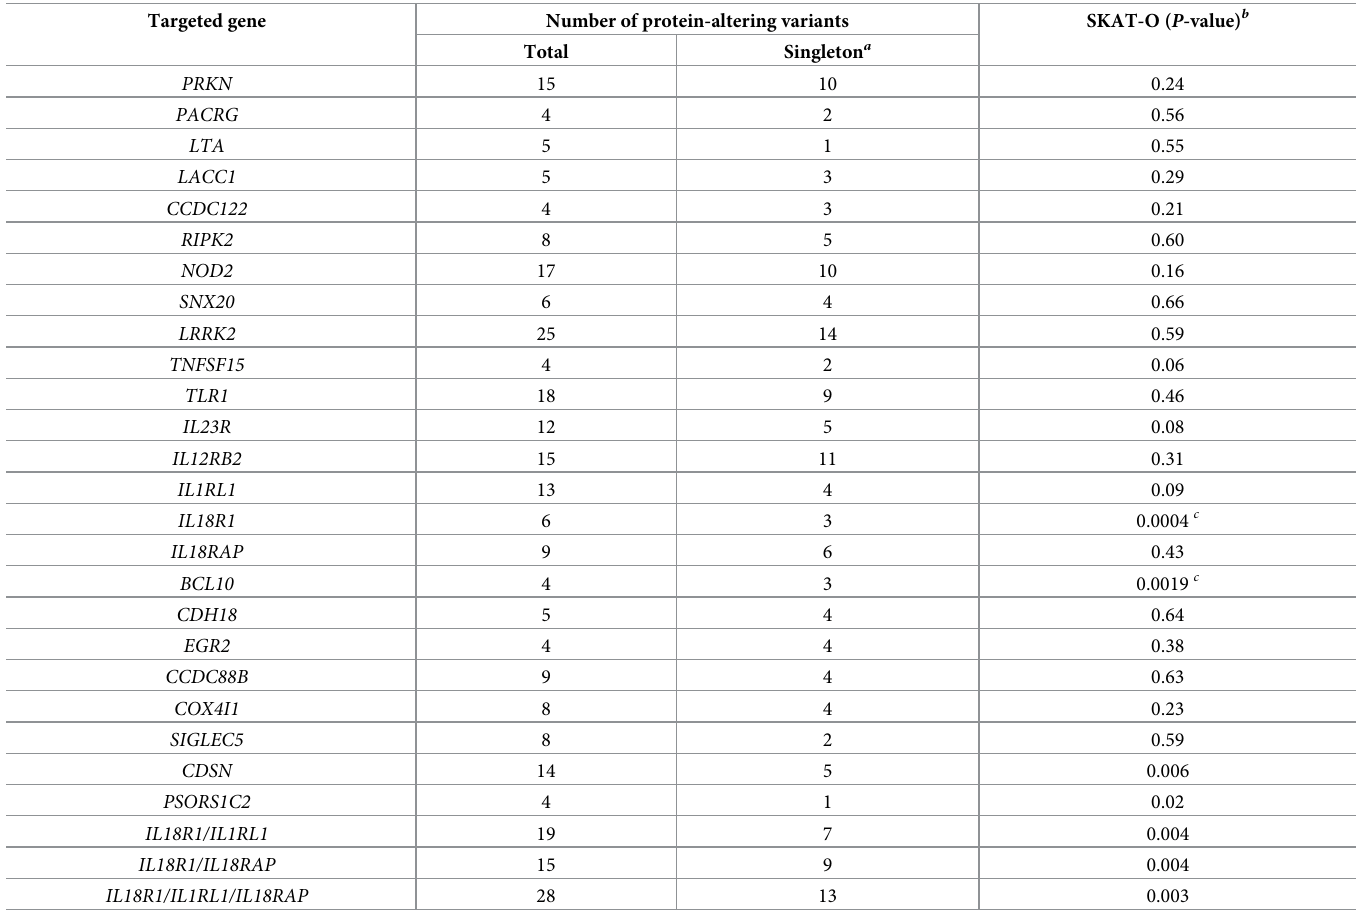
Of the 34 genes targeted for deep resequencing, RAB32 and SOCS1 failed library preparation (S1 Table). For the remaining 32 genes, we identified 770 transcribed variants, of which 234 resulted in altered protein amino acid sequences (S2 Table). Three genes ( TNFSF8 , BATF3 , and ADO ) had no protein-altering variants and five genes ( TNF , IL12B , RMI2 , DEC1 and PSORS1C1 ) had three or less in the studied sample, thus, were not evaluated in the gene-wise analysis (S1 Table). When testing the remaining 24 genes for enrichment or depletion of pro- tein-altering variants in leprosy patients compared to healthy controls, the IL18R1 and the BCL10 genes displayed significant evidence for association with leprosy surpassing the multi- ple testing correction cut-off of P < 0.002 (Table 2). Furthermore, mutations in the CDSN and PSORS1C2 genes located at 1.2kb and 25kb, respectively, from the top SNP (rs1265048) of the novel GWAS hit in the Vietnamese population showed a trend for protection from leprosy. By contrast, none of the remaining genes showed nominal significant evidence of association with leprosy (Table 2). Table 2. Gene-wise analysis of protein-altering variants. Targeted gene Number of protein-altering